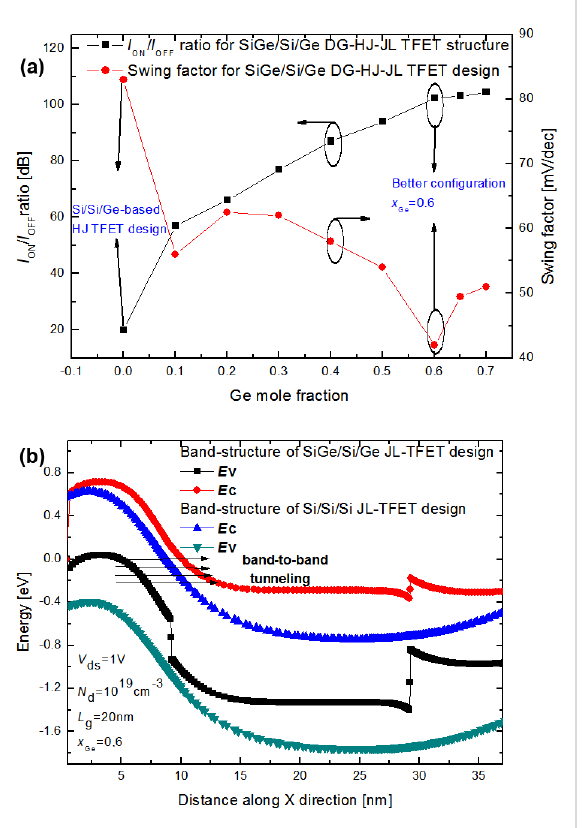
Figure 4: (a) Subthreshold swing factor and the I ON / I OFF ratio as func- tions of the Ge mole fraction for the investigated Si 1 − x Ge x /Si/Ge DG-HJ-JL TFET structure with N d = 1·10 19 cm − 3 , V ds = 1 V, t ox = 2 nm, L g = 20 nm and t ch = 5 nm. (b) Comparison of the band diagrams of the proposed Si 1 − x Ge x /Si/Ge DG-HJ-JL TFET design and the conven- tional structure with uniform Si channel .